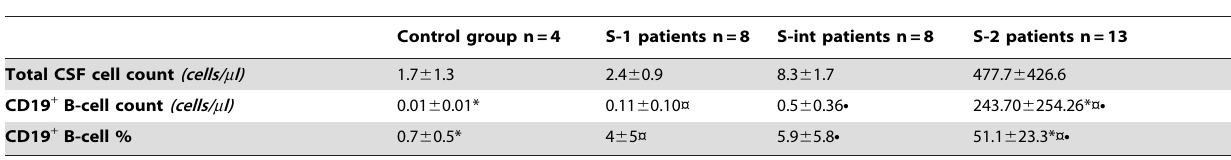
Table 4. B cells (CD19 + ) in the CSF of HAT patients and